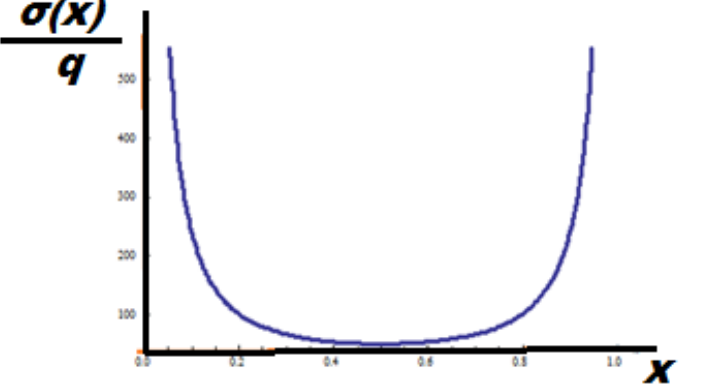
Figure 24. The diagram of the true stress in the initial space.